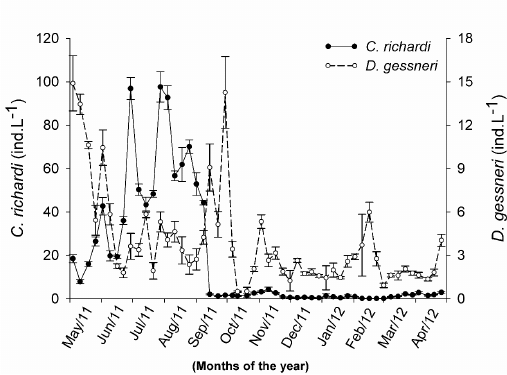
Figure 2. Weekly variation of the densities of the cladocerans C. richardi and D. gessneri in Lake Monte Alegre, from May 2011 to April 2012. Bars are standard error of the means (±) based on three replicates. Note the different scales for the